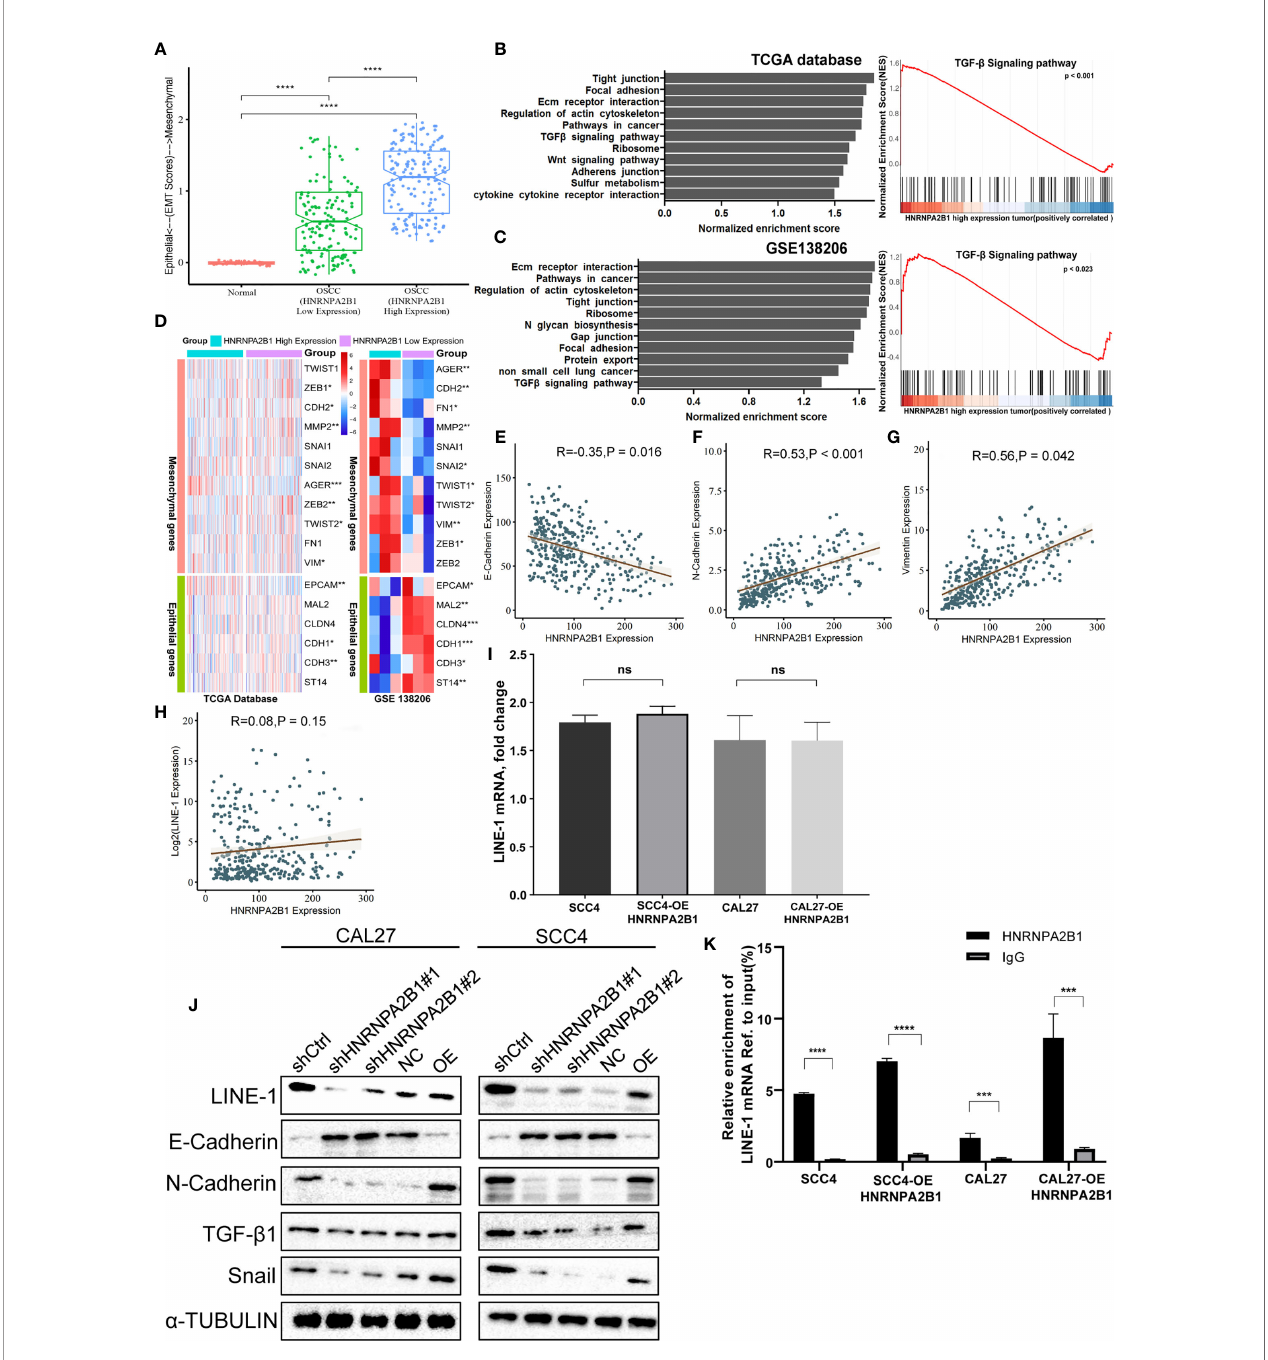
FIGURE 7 | HNRNPA2B1 is correlated with the EMT process in OSCC. (A) EMT scores in normal and OSCC tissues. (B, C) Gene set enrichment analyses show the upregulated genes for HNRNA2B1 high-expression patients compared to low-expression patients. (D) GSE data (GSE138206) and TCGA data show that HNRNPA2B1 is correlated with multiple EMT markers. (E – H) HNRNPA2B1 expression is negatively correlated with E-cadherin (R = -0.35, p < 0.05) expression and positively correlated with N-cadherin (R = 0.53, p < 0.05) and vimentin (R = 0.56, p < 0.05), but was not correlated with the LINE-1 mRNA expression (R = 0.08, p = 0.15). (I) LINE-1 mRNA expression was not correlated with the HNRNPA2B1 expression in OSCC cell lines. (J) Western blot analysis of EMT markers related with LINE-1/TGF- b 1/Snail signaling pathway. Protein levels of N-cadherin, E-cadherin, TGF- b 1, Snail, and LINE-1 ORF1 of CAL27 and SCC4 cells were detected by Western blot after HNRNPA2B1 was knocked down or overexpressed. (K) Relative enrichment of LINE-1 mRNA associated with HNRNPA2B1 protein was identi fi ed by RIP assays using anti-IgG and anti-HNRNPA2B1 antibodies. The IgG group was a negative control to preclude nonspeci fi c binding. The Y-axis represents the percent of input for each IP sample according to the formula: %Input =1/10*2 Ct [IP]-Ct [input] . *, **, *** and **** indicated p<0.05, p<0.01, p<0.001 and p<0.0001, respectively. “ ns ” indicates no signi fi